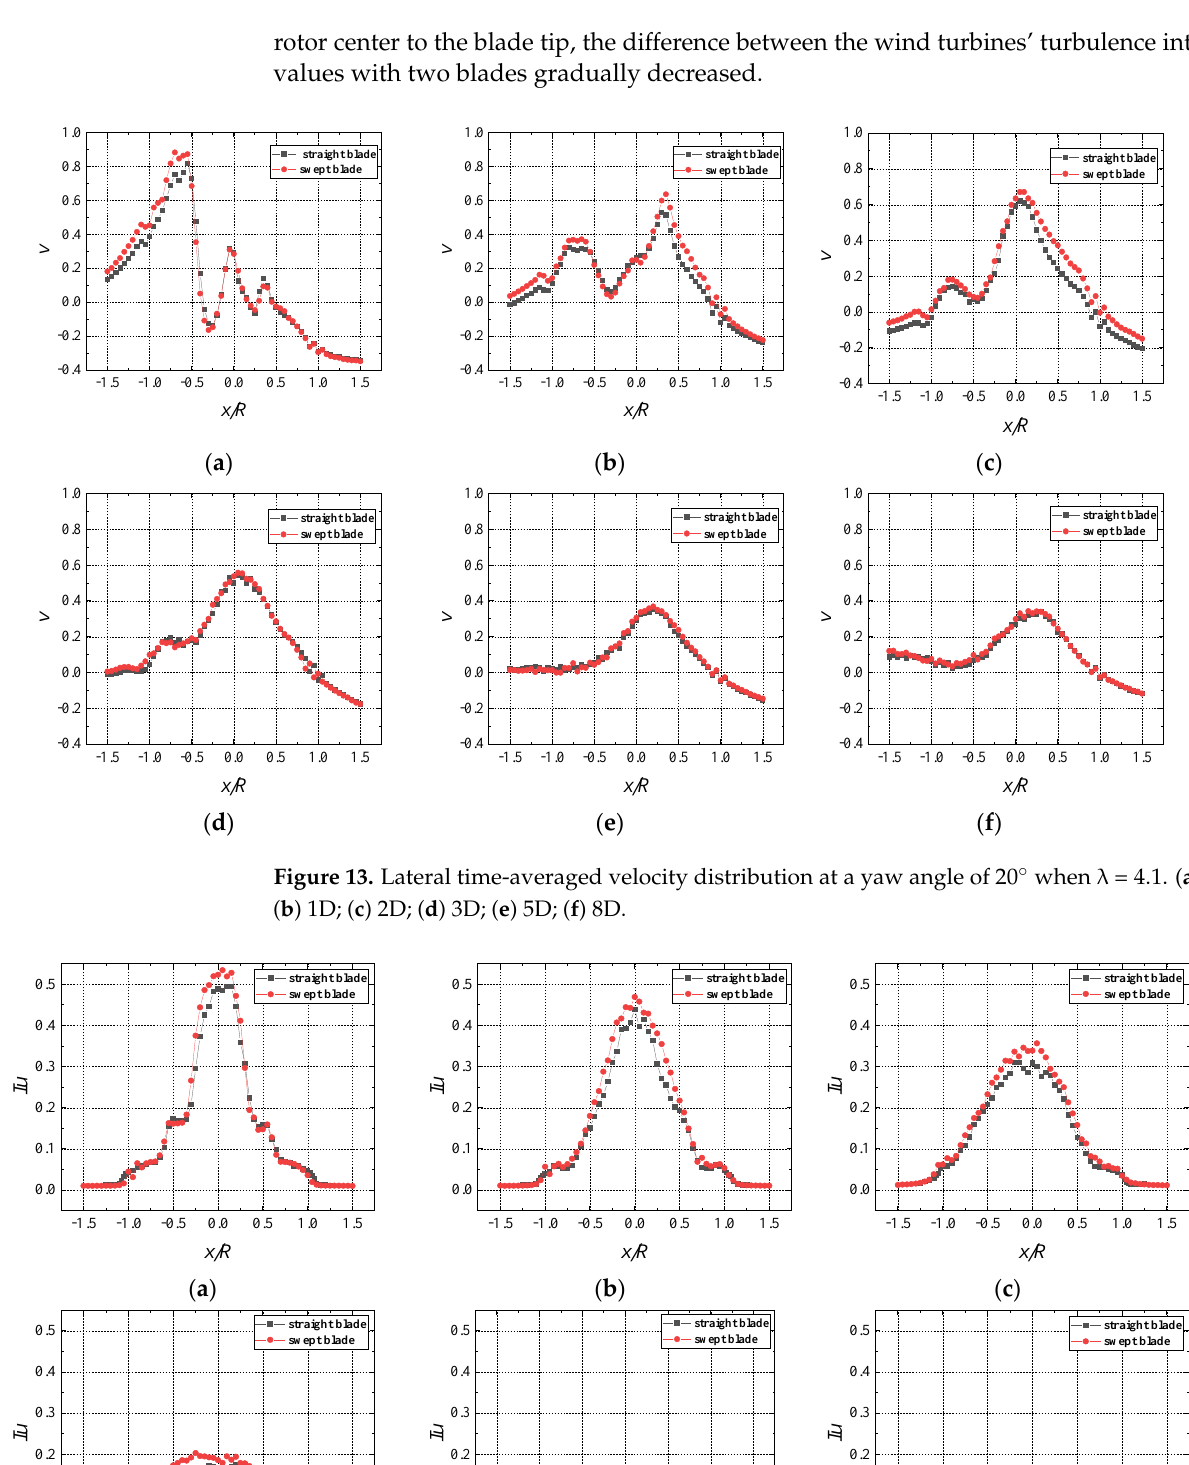
( f ) Figure 12. Streamwise time-averaged velocity distribution at a yaw angle of 0° when λ = 4.67 . ( a ) 0.5D; ( b ) 1D; ( c ) 2D; ( d ) 3D; ( e ) 5D; ( f ) 8D. The lateral velocities of the wake produced by the wind turbine without yaw were low, but they would become larger in yaw conditions. As shown in Figure 13, in the near wake region, due to the blade tip turbulence, the formation of the wake vortex was rela-